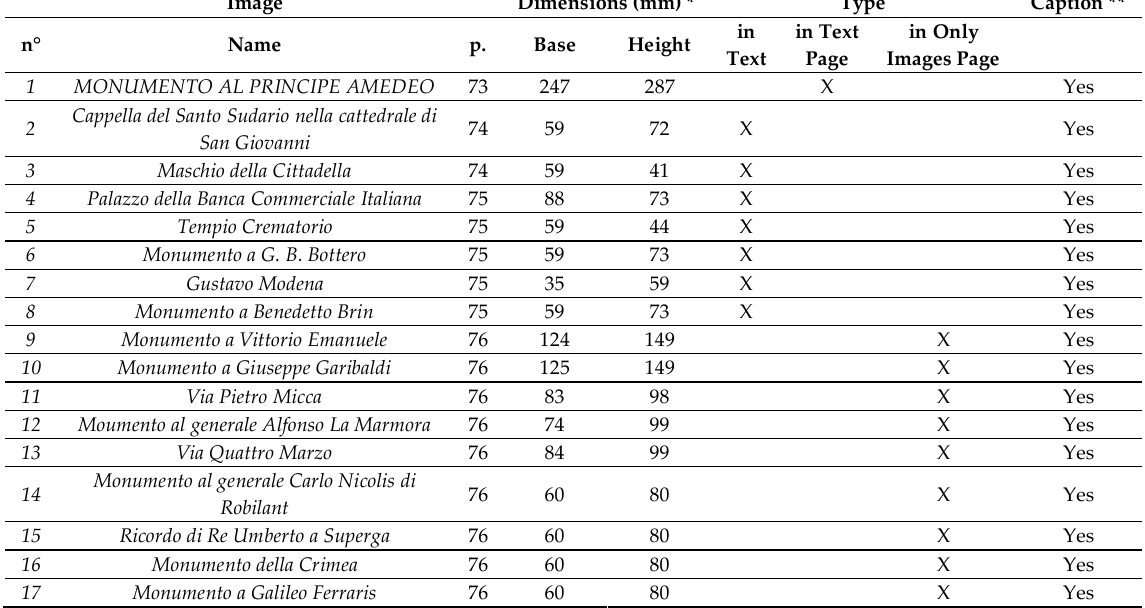
Table 1. Images in Torino Nuova [33].